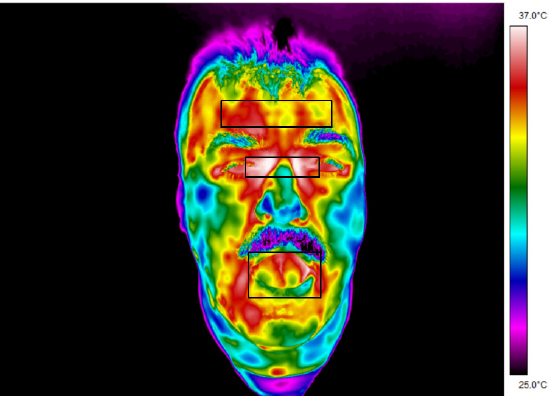
Figure 3. Thermogram 1 showing the temperature map of the subject’s facial surface.